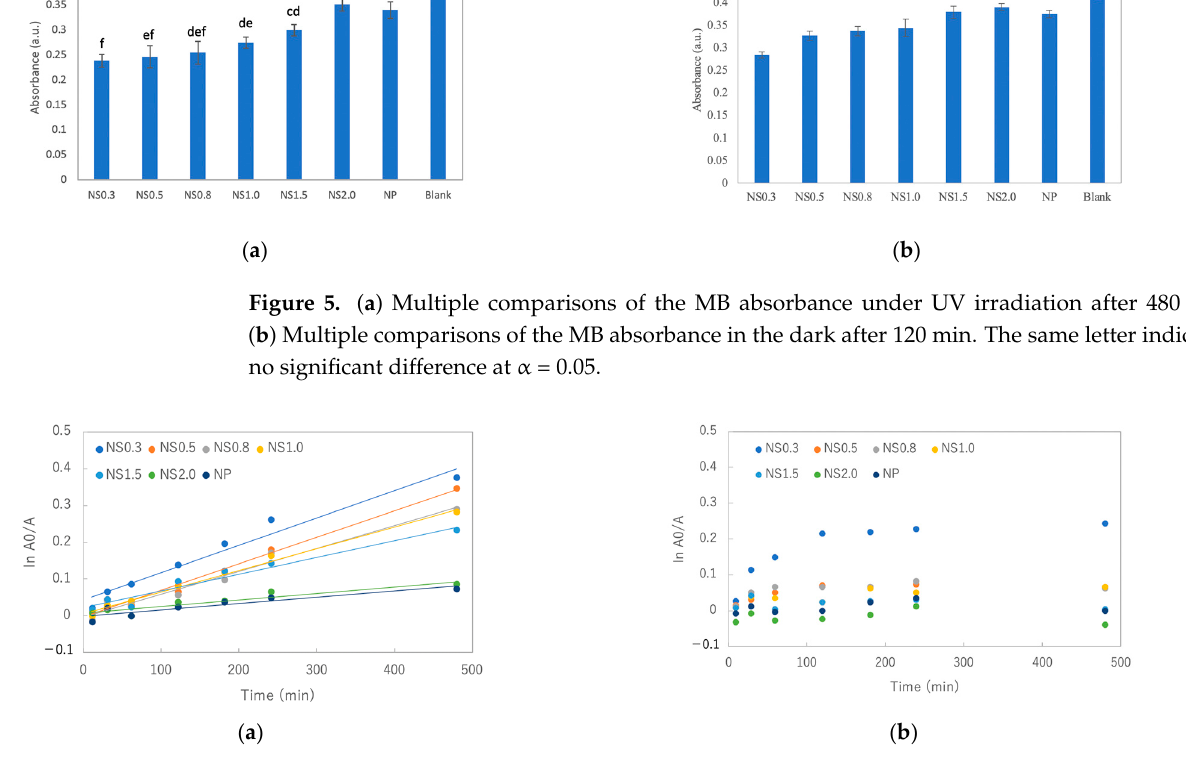
Figure 6. Variation of ln(Ao/A) of MB with reaction time ( a ) under UV irradiation and ( b ) in the